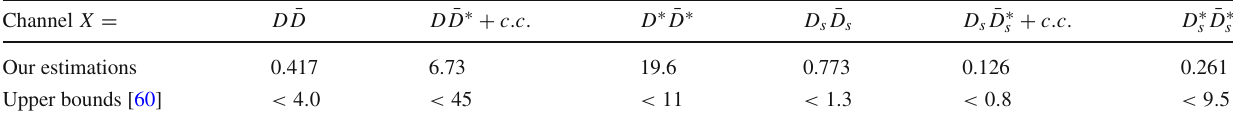
tot . denotes the summation